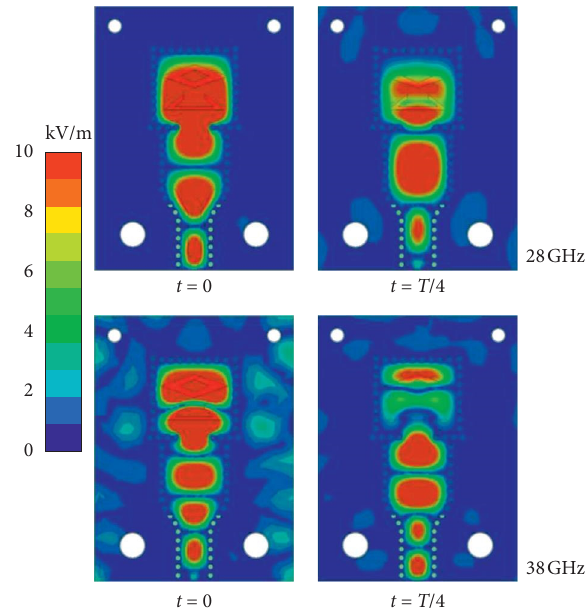
Figure 2: Distributions of the E-feld of the proposed unit